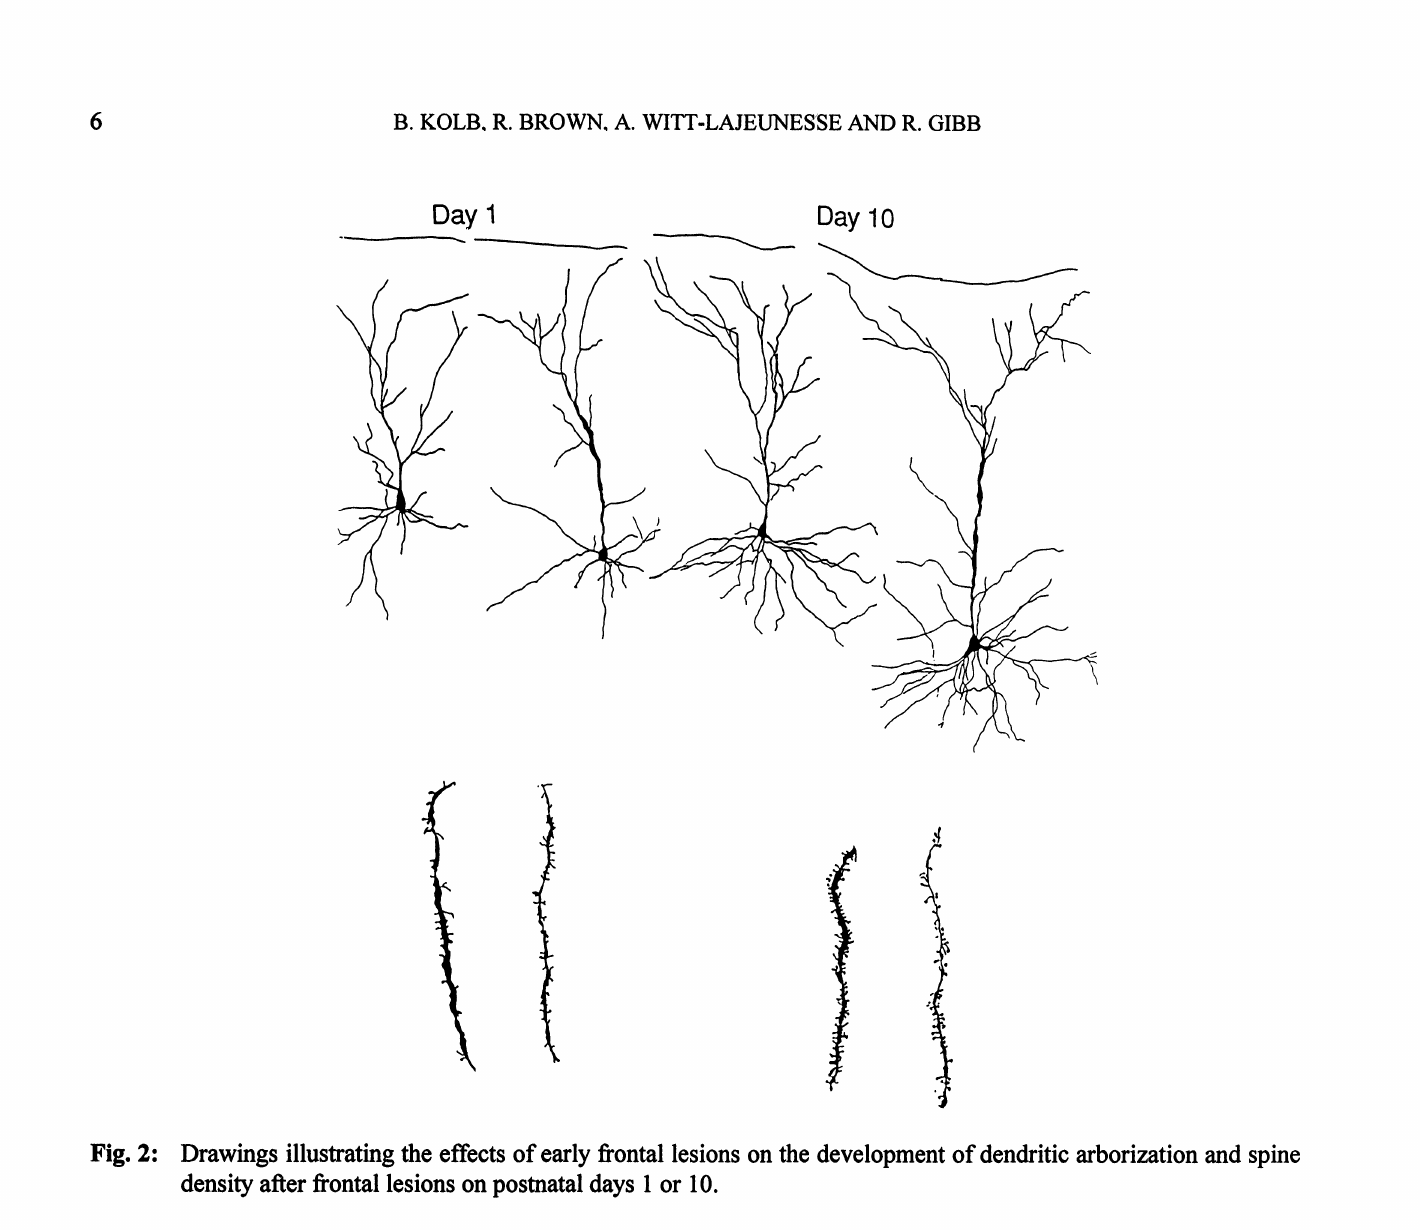
Fig. 2: Drawings illustrating the effects of early frontal lesions on the development of dendritic arborization and spine density atter frontal lesions on postnatal days or